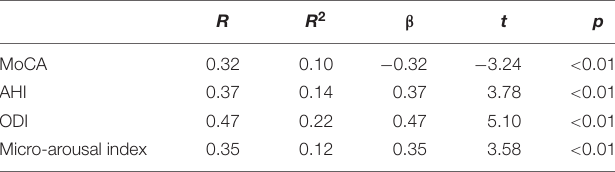
TABLE 2 | The results of univariate linear regression analysis.